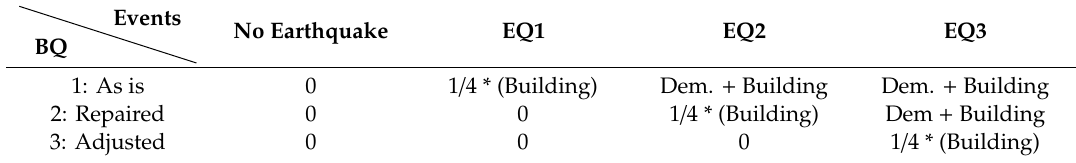
Table 8. Interventions due to seismic event occurrence and building quality (BQ).